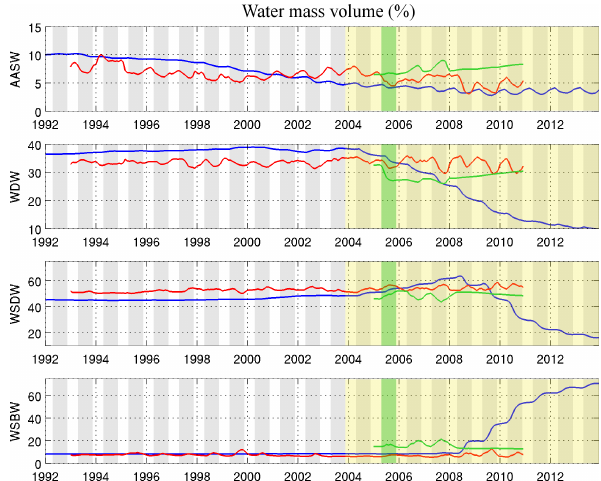
Figure 3. Percentage of the Weddell Sea sector occupied by the water masses, in volume. From top to bottom, the charts show the volumes for Antarctic Surface Water (AASW), Warm Deep Wa- ter (WDW), Weddell Sea Deep Water (WSDW) and Weddell Sea Bottom Water (WSBW). The red, blue and green lines are for the UR025.4, ECCO2 and SoSE reanalyses, respectively. Green and yellow shadings highlight the period in which the polynyas are open in SoSE and ECCO2,